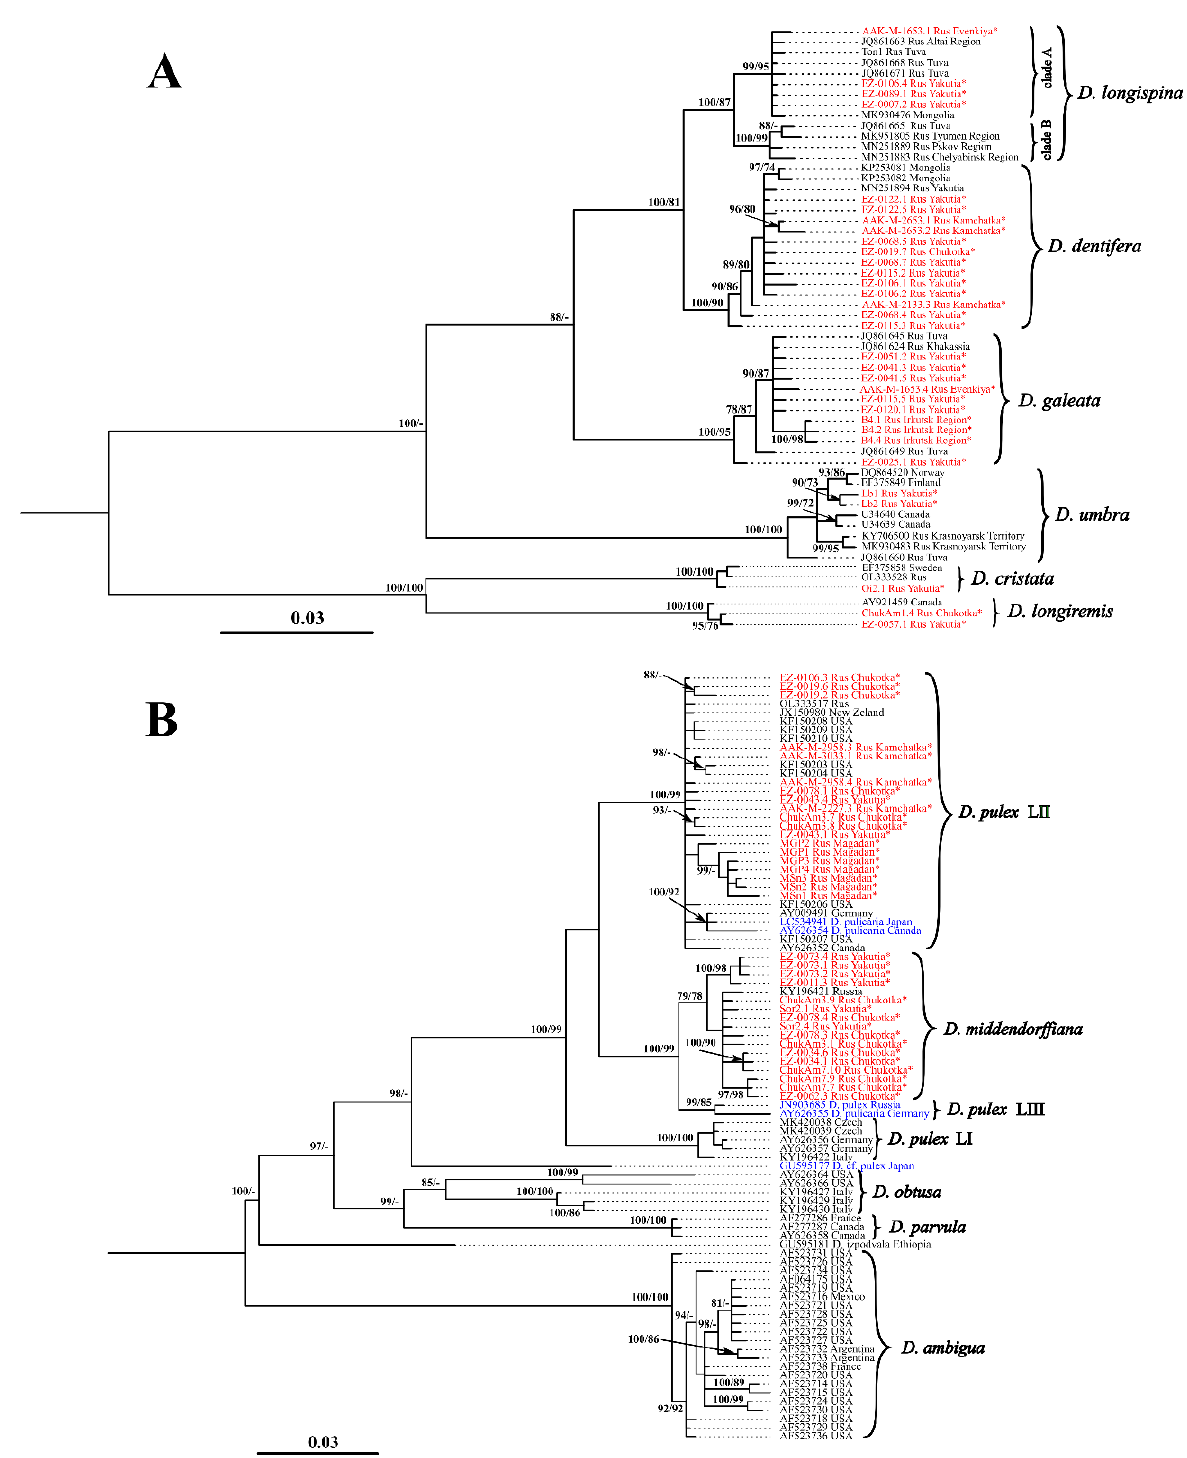
Figure 2. Bayesian phylogenetic tree for the Daphni a species based on the 12S sequences (original and obtained from the GenBank database, Table S2). Bayesian posterior probabilities BI and boot- strap values from ML analysis above 72% expressed as a percentage are indicated for each signifi- cant node; red *—new nucleotide sequences; blue—ambiguous specific status of the GenBank se- quences. Scale is given in expected substitutions per site.